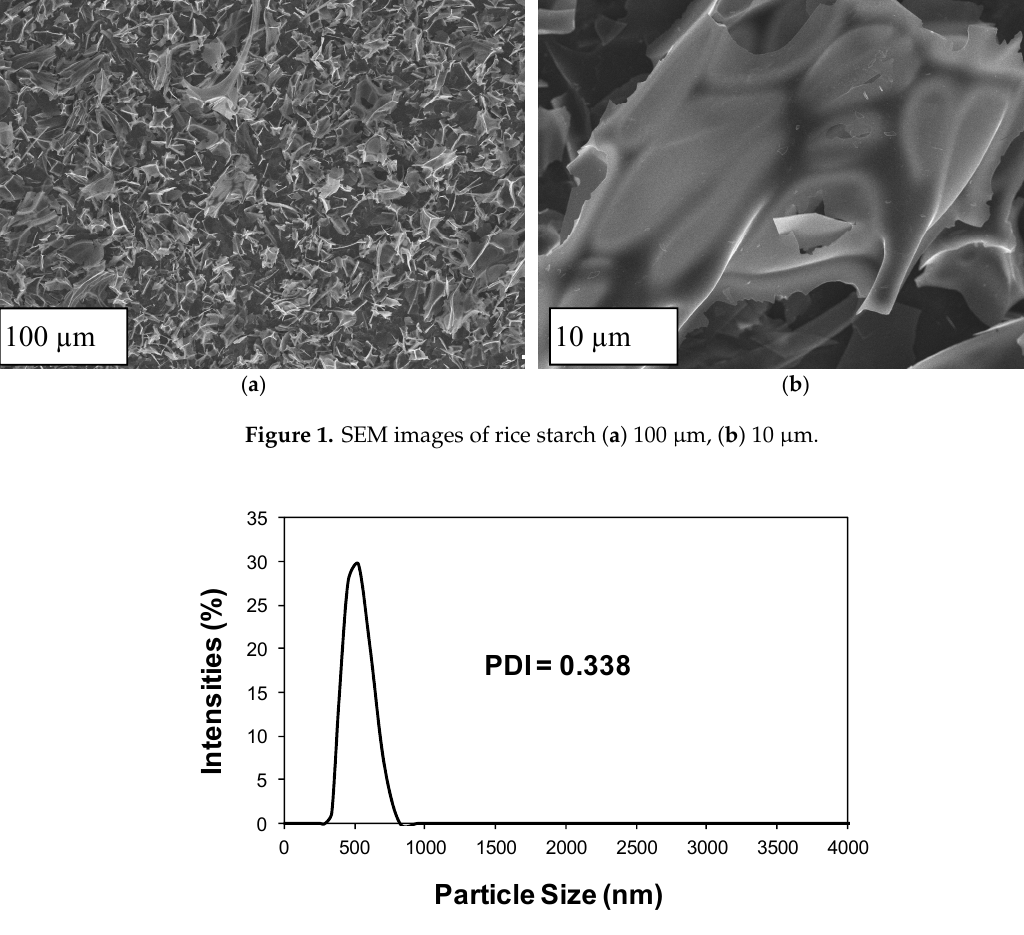
Figure 2. Distribution of the particle sizes for rice starch.